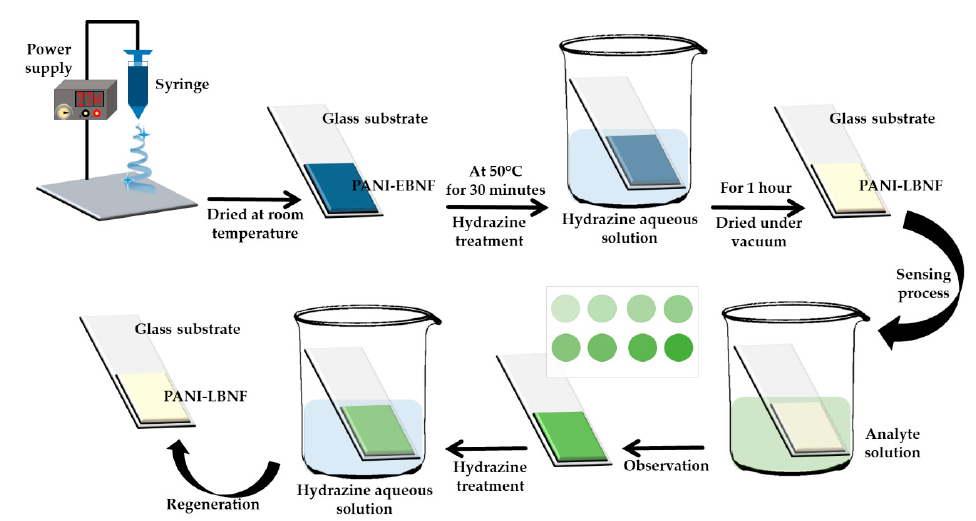
Figure 4. Schematic representation of preparation on fully reduced polyaniline (PANI-LB) sensing membranes [64].